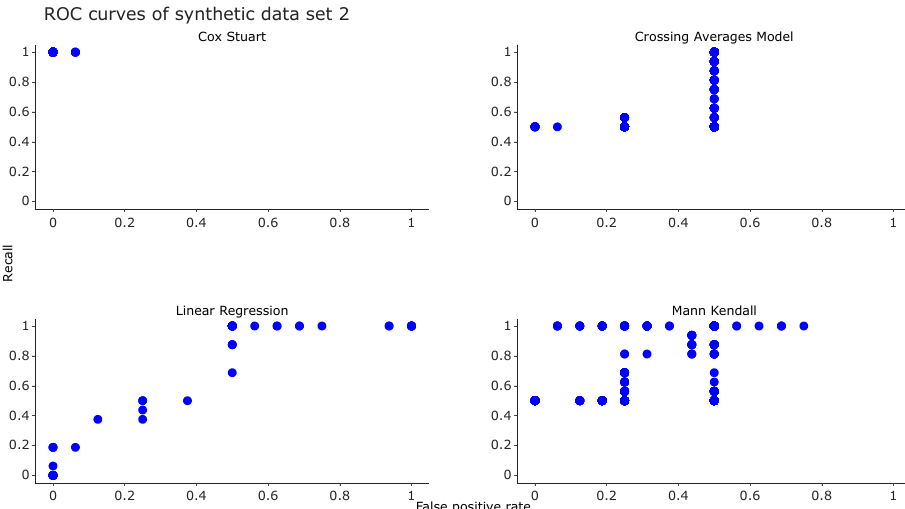
Figure 7. Trend detection model comparison based on the synthetic data set 1.